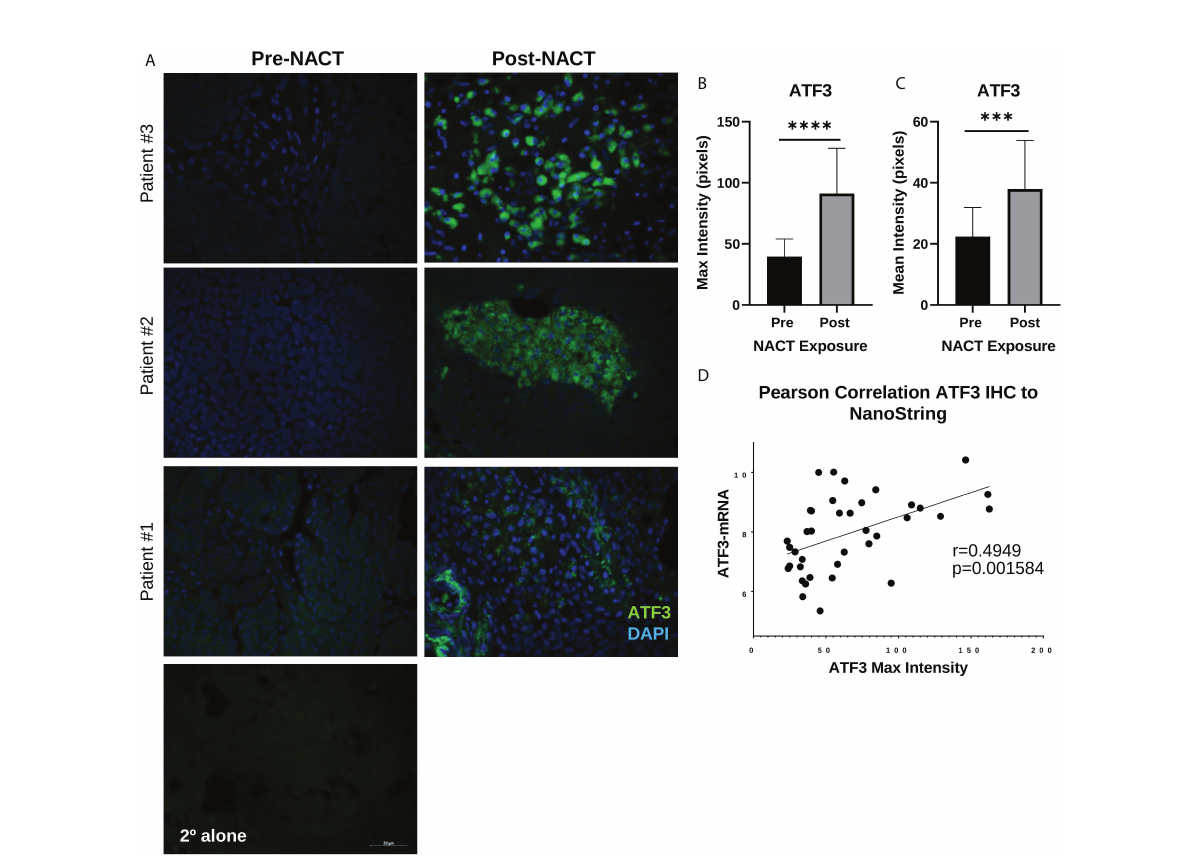
FIGURE 4 ATF3 protein displays distinct regional nuclear and cytoplasmic upregulation in human HGSOC tissue post-NACT. (A) Representative IHC images of ATF3 protein in three different patients pre-NACT and post-NACT. ATF3 = green; DAPI (nuclear) = blue. 2° alone = secondary antibody control. (B) Quanti fi cation of ATF3 maximum intensity pre-NACT and post-NACT. (C) Quanti fi cation of ATF3 mean intensity pre-NACT and post-NACT. Signi fi cance was calculated using 1-tailed, unpaired student t test (n=20 patients). ***p<0.0005; ****p<5e-5 (D) Pearson correlation of ATF3 maximum intensity levels with NanoString RNA